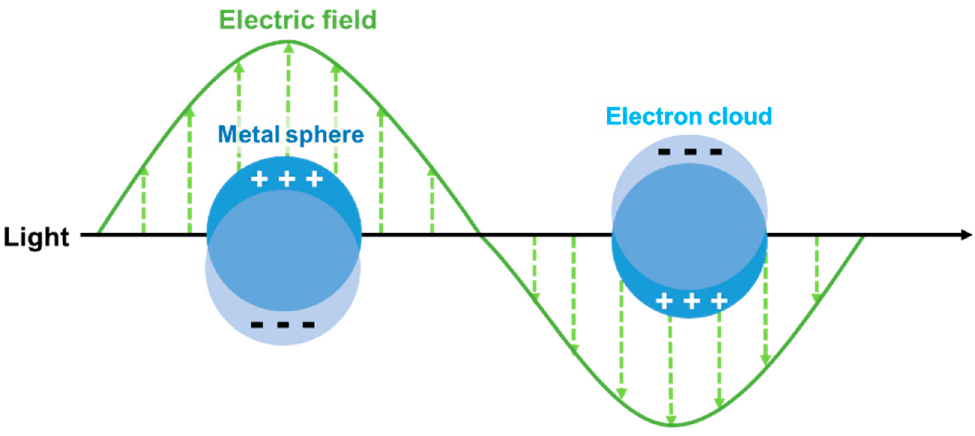
Figure 2. Localized surface plasmon oscillations in noble metal nanoparticles.